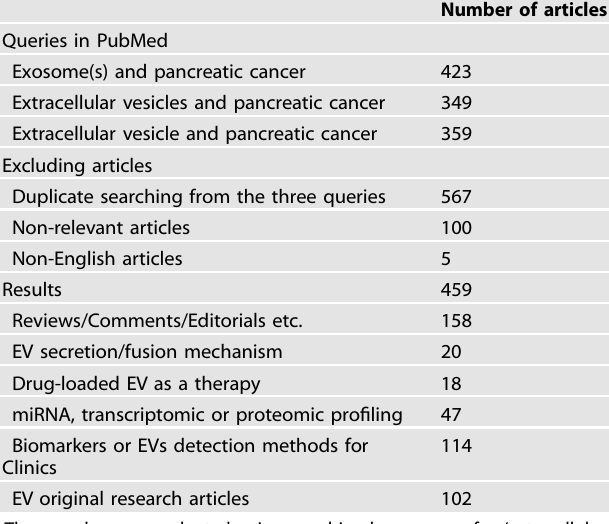
Table 1. Summary of EV relevant literature search from PubMed till 24 June